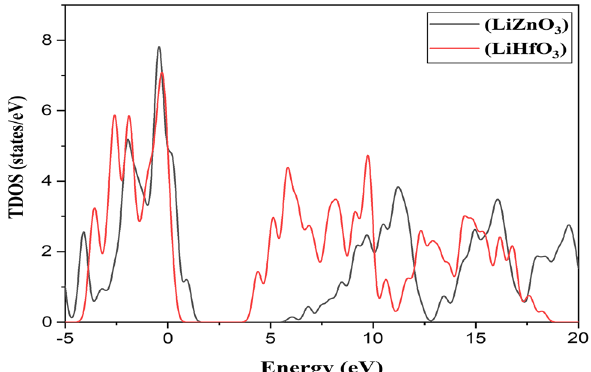
Fig. 4 Total DOS of LiZnO